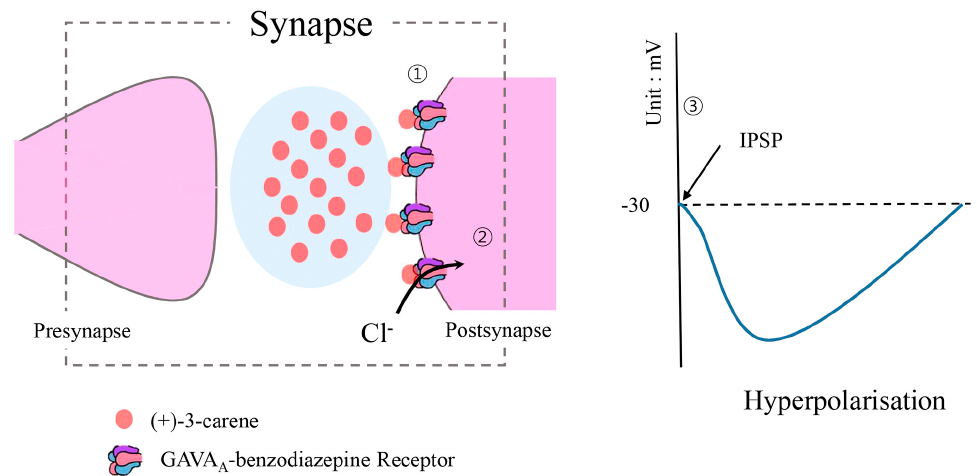
Figure 1. Mechanisms by which (+)-3-carene enhances sleep by stimulating the GABA A -benzodiazepine receptor (modified from Woo et al. 2019 [20]). ○ 1 (+)-3-carene binds on the GABA A -benzodiazepine receptors in the postsynaptic region. ○ 2 Cl − flows into the postsynapse. ○ 3 Inhibitory postsynaptic potential (IPSP) occurs, thus enhancing the quality and the duration of sleep under hyperpolarization. : (+)-3-carene; : GABA A -benzodiazepine receptor.